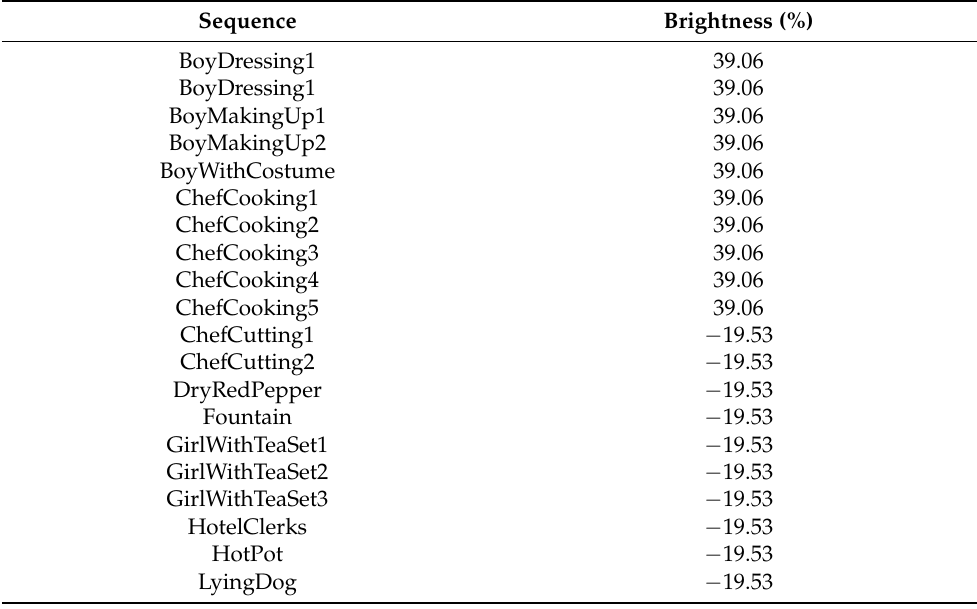
Table 1. Data augmentation by brightness adjustment of